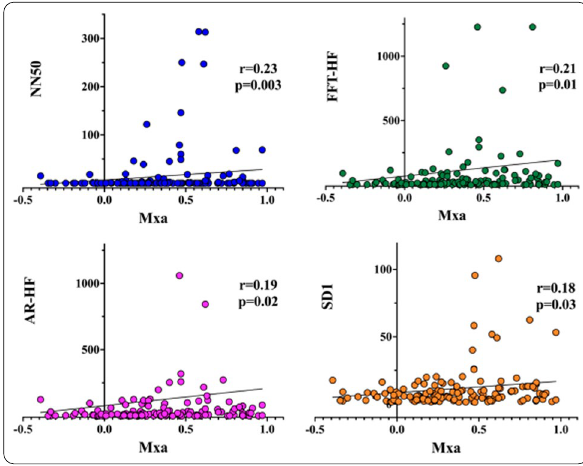
Intensive Care Unit; ICPm =